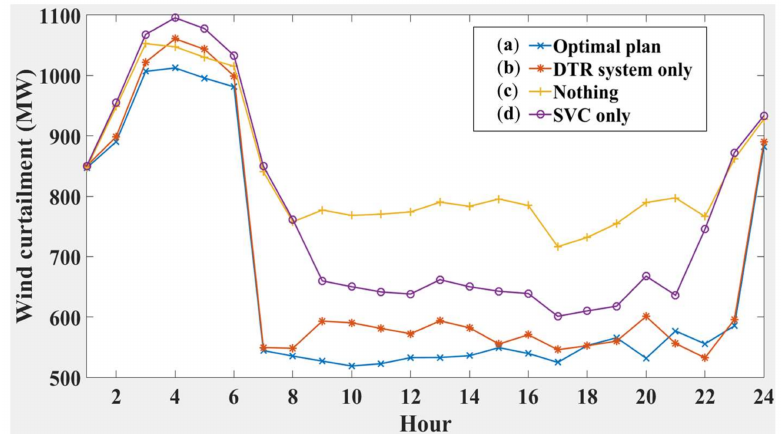
Figure 5. Wind energy curtailment level using the ( a ) optimal plan, ( b ) optimal plan but with the DTR system only (DTR system only), ( c ) optimal plan but with the SVC only (SVC only), and ( d ) without any enhancement (Nothing).